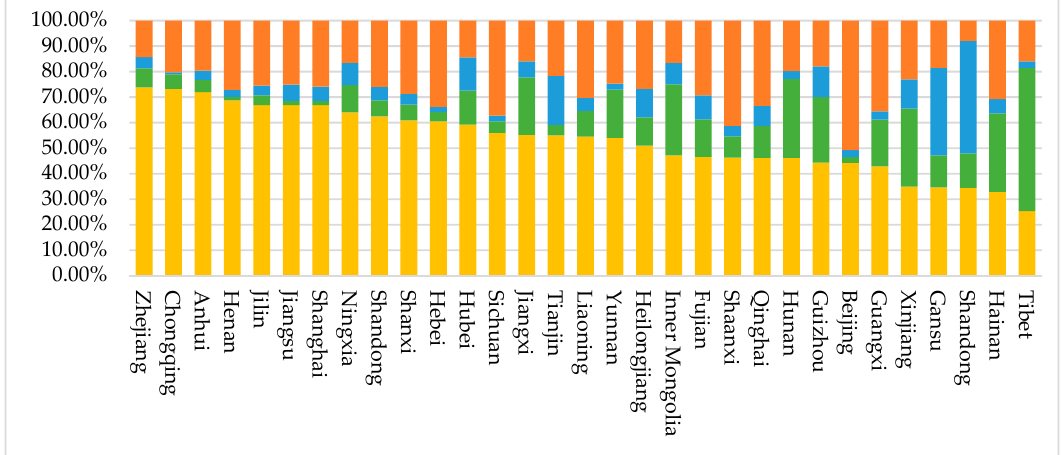
Figure 11. Proportion of land use occupied by urban sprawl areas of China’s cities 2000–2015.